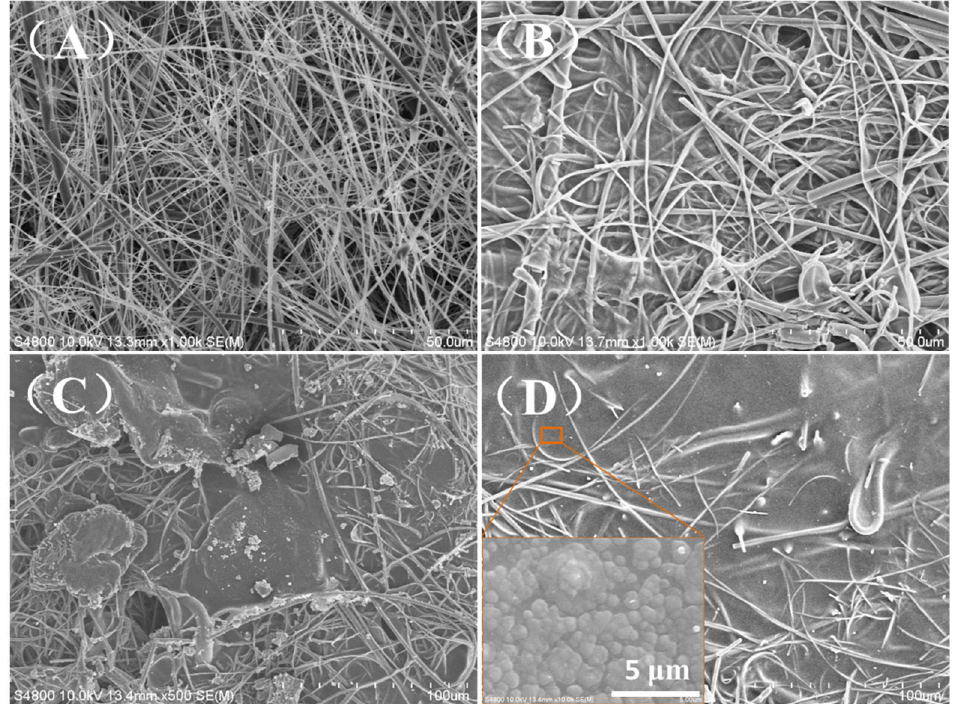
Figure 3. TGA curves of chitosan and PVA.